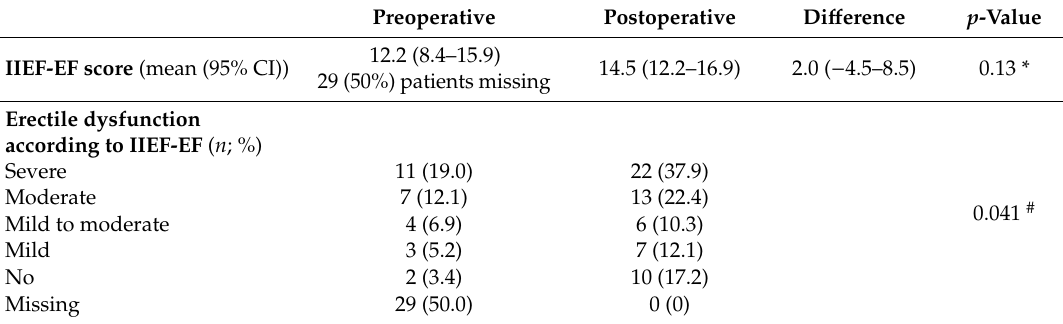
Table 2. Change in preoperative and postoperative erectile function in 58 patients treated with small intestinal submucosa grafting for Peyronie’s disease. Preoperative